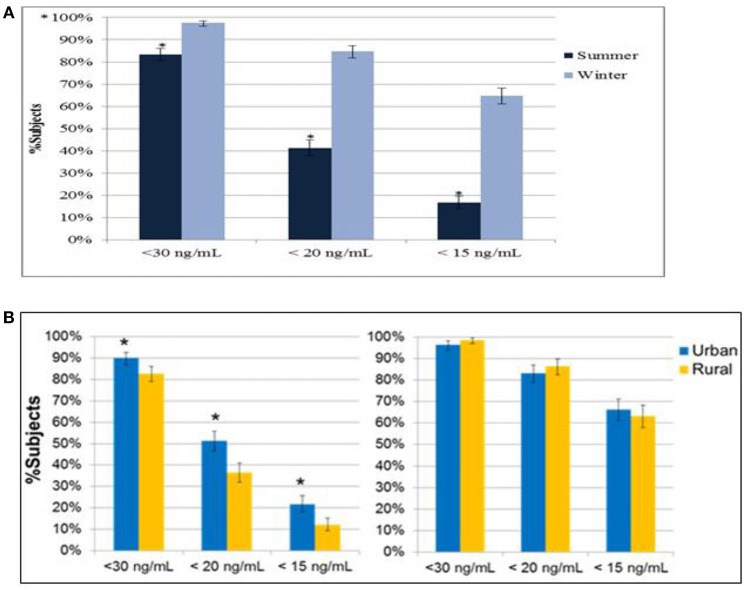
(A) Prevalence of vitamin D inadequacy by season. *P < 0.01 from Chi-square test of the comparison of summer vs. winter subjects. (B) Prevalence of vitamin D inadequacy in urban and rural dwellers. *P < 0.01 from Chi-square test of the comparison of urban vs. rural dwellers.